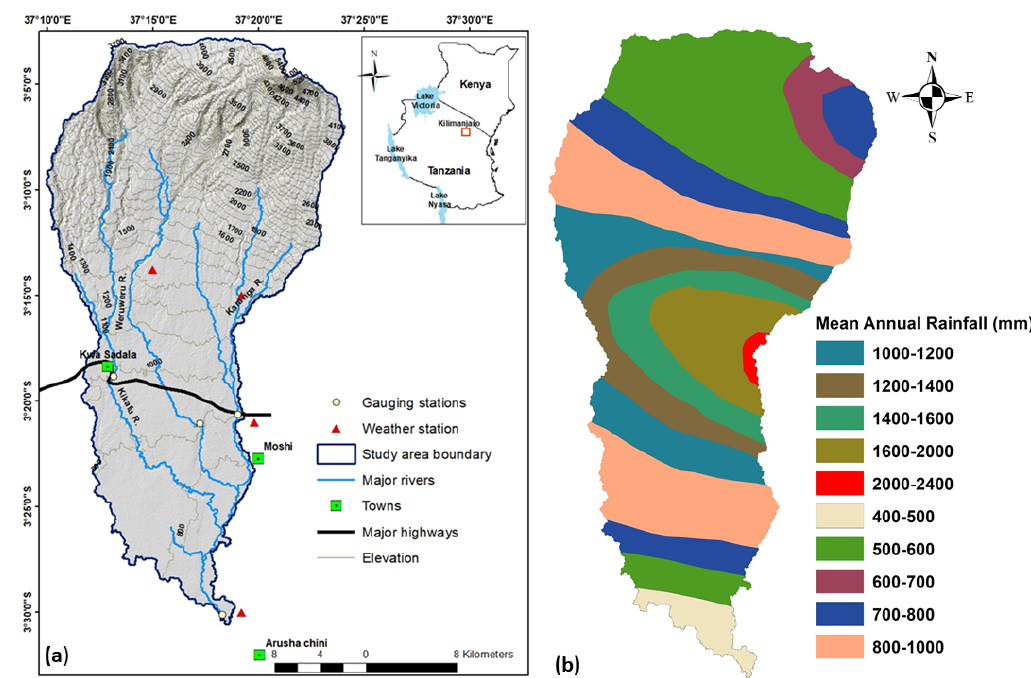
Figure 1. Location of KWK watershed (a) and mean annual rainfall (b).